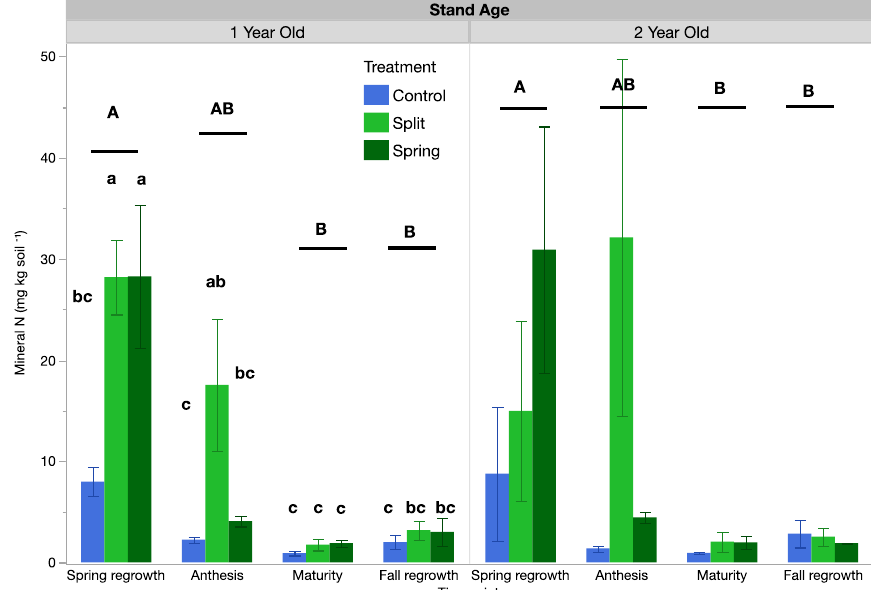
Figure 5. Soil mineral N in 1-year-old and 2-year-old intermediate wheatgrass fields across sampling times and nitrogen fertilization treatments. Within a field, bars with the same or no lowercase letter are statistically similar in terms of treatment effects as per Tukey’s HSD ( p = 0.05). Control = 0 kg N ha −1 ), split = 40–40 kg N ha −1 , and spring = 80 kg N ha −1 . Within a field, sets of bars with the same uppercase letter did not differ between sampling times as per Tukey’s HSD ( p = 0.05).